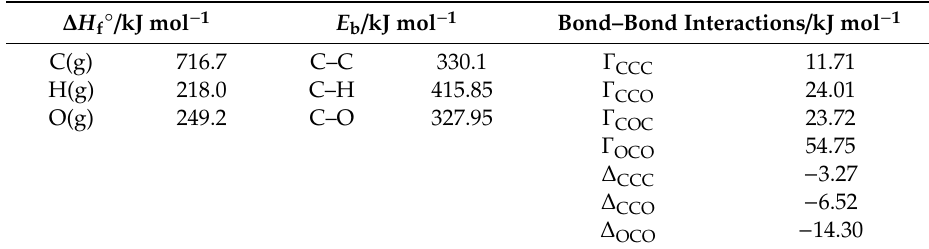
Table 4. The values of the enthalpies of formation ∆ H f ◦ of gaseous atoms, the bond energies E b and the bond–bond interactions needed to estimate the enthalpies of formation for the theoretically strain-free gaseous compounds 1 to 4